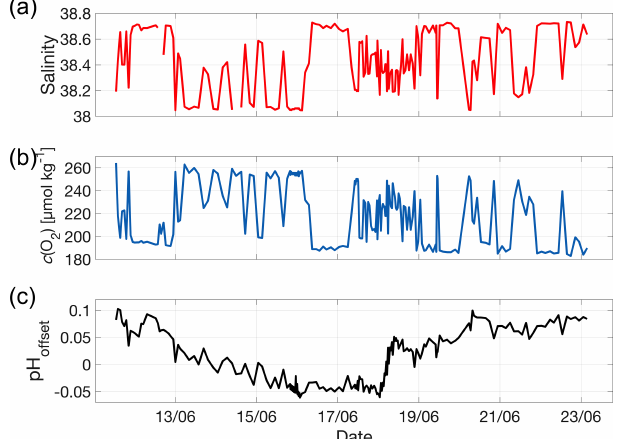
Figure 9. Salinity (a) , dissolved oxygen concentrations ( c (O 2 )) (b) , and the calculated pH offset values (c) as a function of time at the depth where the in situ temperature was 14 ± 0.1 ◦